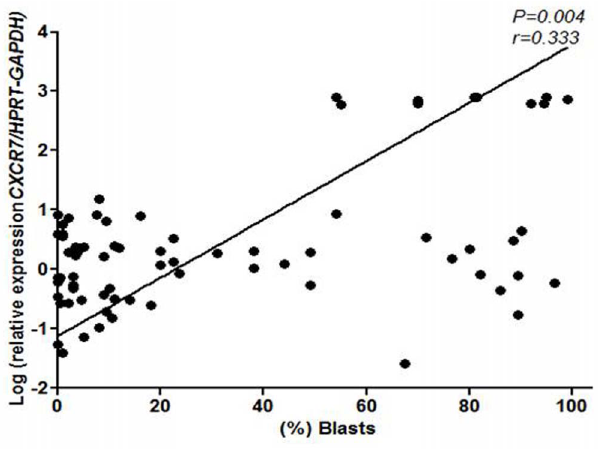
Figure 3. CXCR7 positively correlates with the percentage of blasts in the bone marrow. Correlation of log-transformed relative expression of CXCR7/HPRT-GAPDH and the percentage of blasts in the bone marrow of MDS, AML and ALL patients showed CXCR7 expression levels to be positively correlated with bone marrow blast counts ( P=0.004 ). Two-tailed Spearman ’ s correlation. The number of individ- uals is shown in the figure.